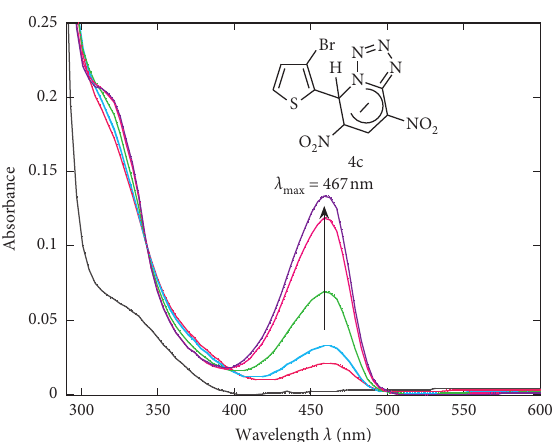
Figure 1: UV-visible spectrum of thiophene 1c and the progressive evolution of the formation of the product 4C in acetonitrile at 20 ° C with [ 1c ] � 1mol · L − 1 and [ 2a ] � 5.10 − 5 mol · L − 1